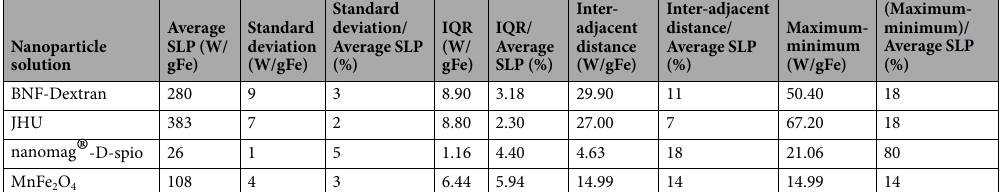
Table 2. Summary of variation of SLP measurements at 150 kHz and 20 kA/m. Note: In addition to average SLP, additional measures of variation are provided - standard deviation, interquartile range (IQR), inter-adjacent distance, and the difference between the maximum and minimum calculated SLP values. The ratio of these different measures of variation and the average indicate a relative inherent variance to estimated SLP. SLP of